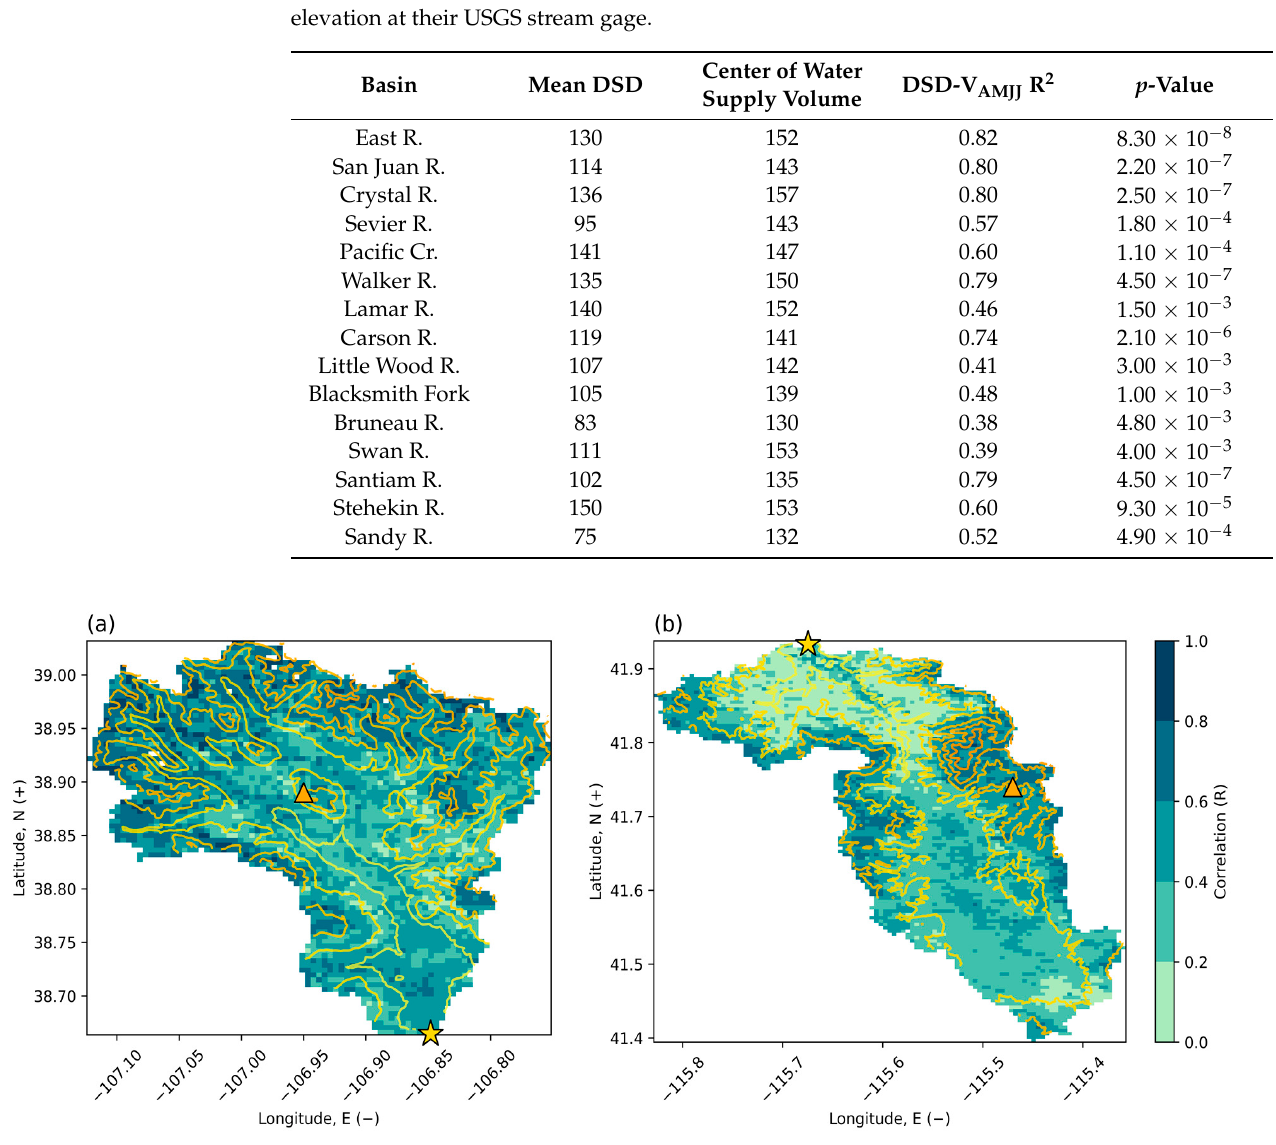
Figure 2. Absolute correlation between V AMJJ and DSD for the years of 2001–2019 spatially illustrated for the example basins of the East R. at Almont, CO, ( a ) and the Bruneau R. at Rowland, NV, ( b ) at the native MODIS resolution of 500 m. The location of the USGS gage and SNOTEL station are denoted by a yellow star and orange triangle, respectively. Contour lines range from yellow (lowest) to orange (highest) elevations. Table 3. Relationships between mean DSD, center of water supply volume, and V AMJJ for the 15 selected study basins. R 2 and p -value from OLS model fi t statistics using all years of available spa- tially aggregated DSD and USGS stream gage data. Basins are sorted from highest to lowest eleva- tion at their USGS stream gage.